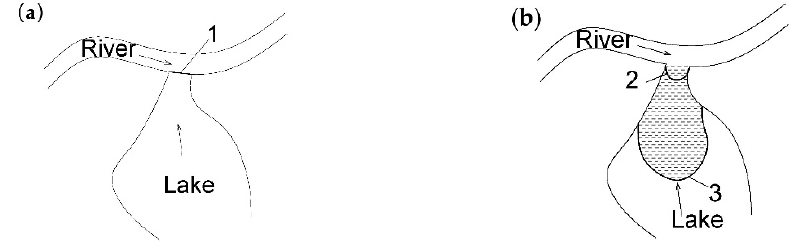
Figure 3. Schematic processing of backflow from river to lake (BRL). ( a ) the beginning of the BRL; ( b ) the processing and the influence scope of the BRL.